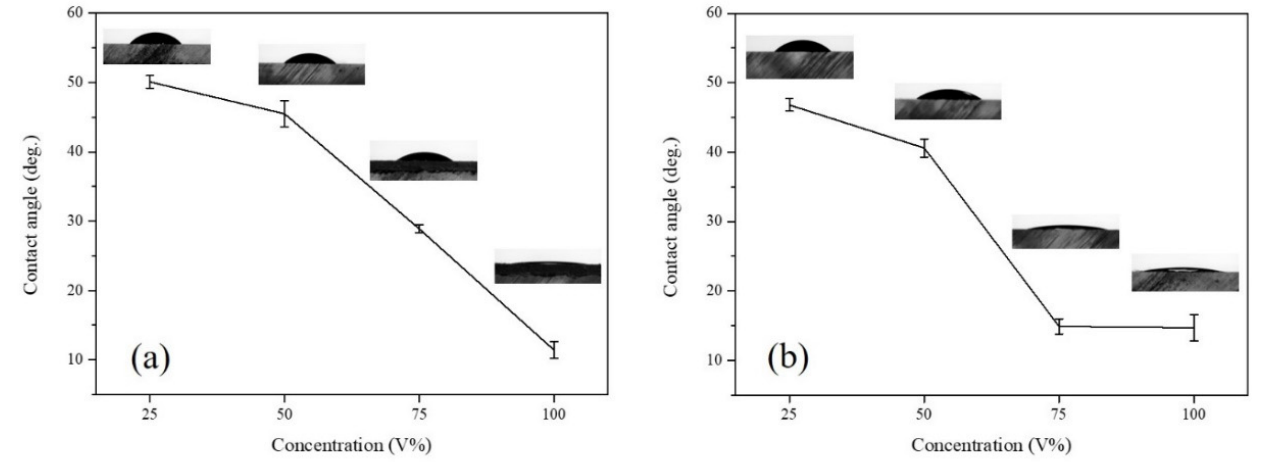
Figure 5. Contact angle measurements of 25~100%; ( a ) acetone, ( b ) ethanol concentrations of PMMA surface.